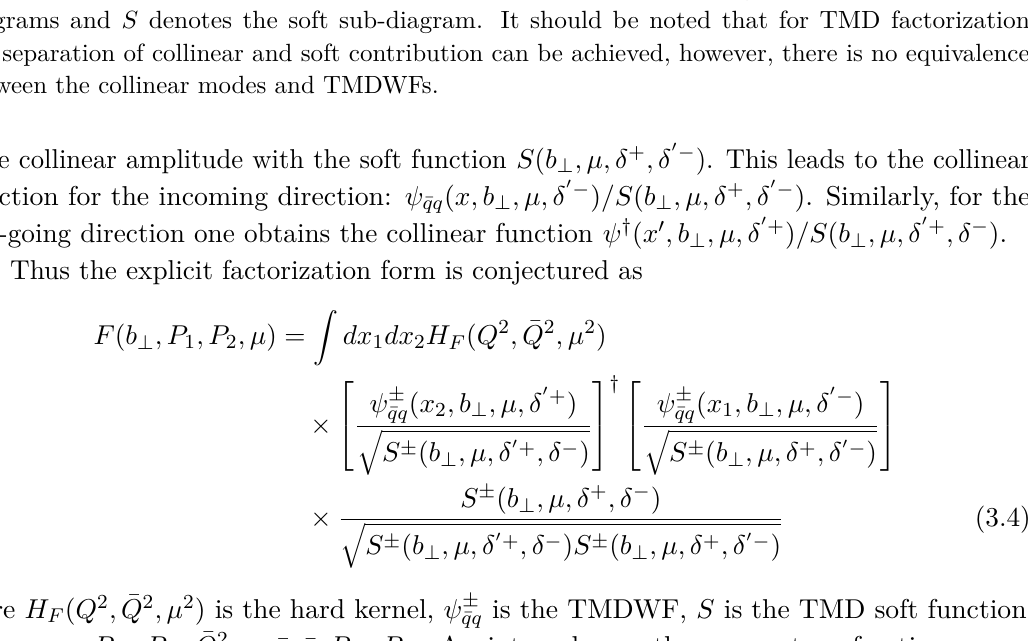
, C are collinear sub- ⊥